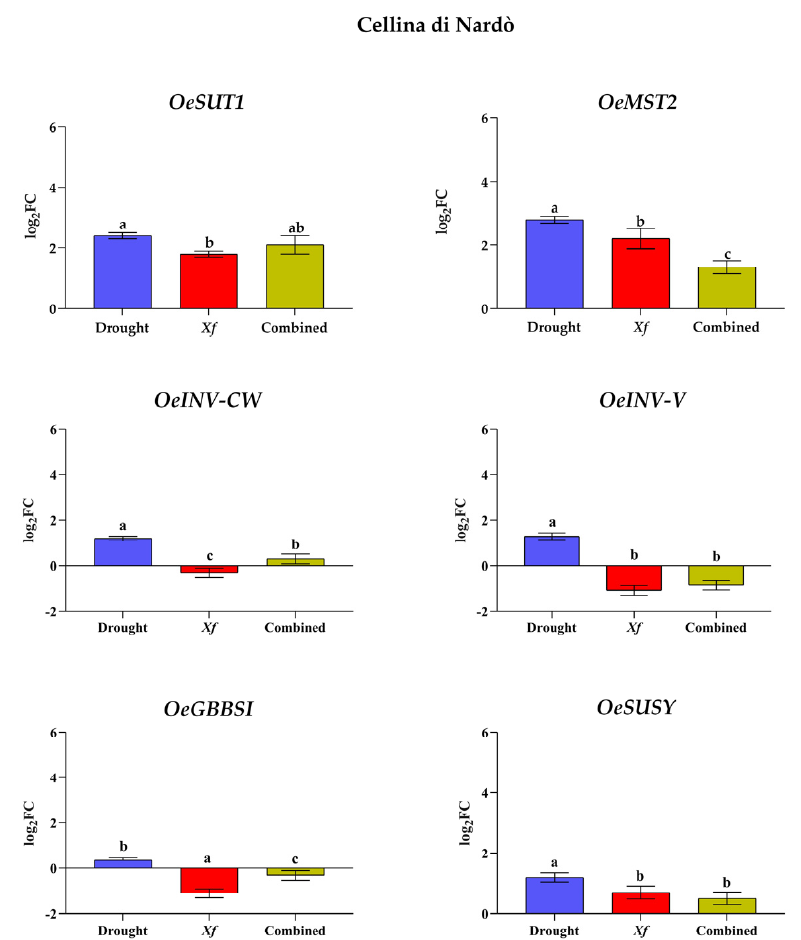
Figure 3. Expression analysis genes involved in sugar metabolism and transport in leaves of Cellina di Nardò cultivar subjected to stresses: drought, pathogen Xylella fastidiosa , and combination of both, expressed as log 2 fold change (log 2 FC) relative to controls. Quantitative analyses of expression of genes coding for the sucrose transporter ( OeSUT1 ); the monosaccharide transporter ( OeMST2) ; the cell wall invertase ( OeINV-CW ); the vacuolar invertase ( OeINV-V ); the granule-bound starch synthase I ( OeGBSSI ); the sucrose synthase ( OeSUSY ). Statistical analysis was carried out through one-way ANOVA with Tukey-HSD post hoc test. Within cvs., different letters correspond to statistically different means.